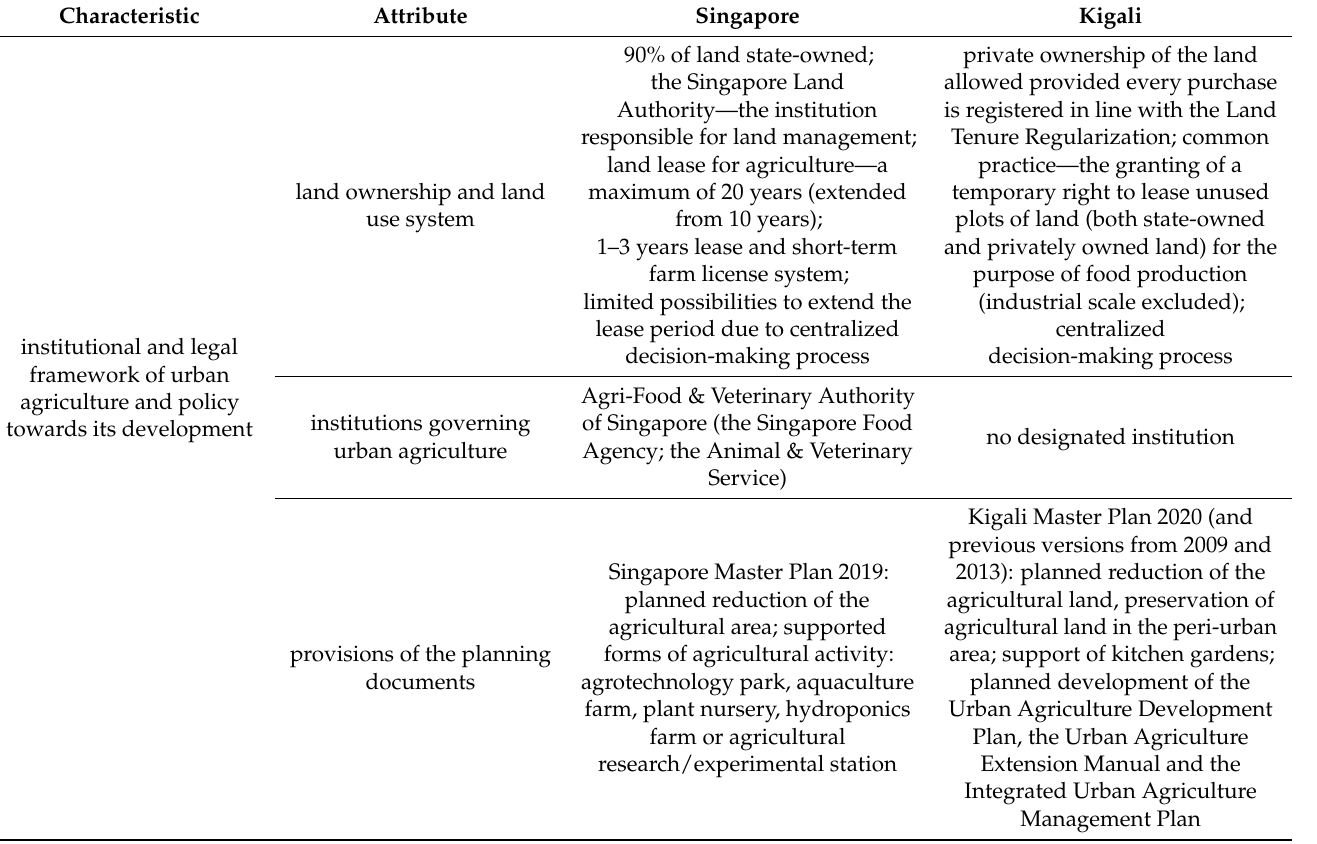
Table 1. Research results for Singapore and